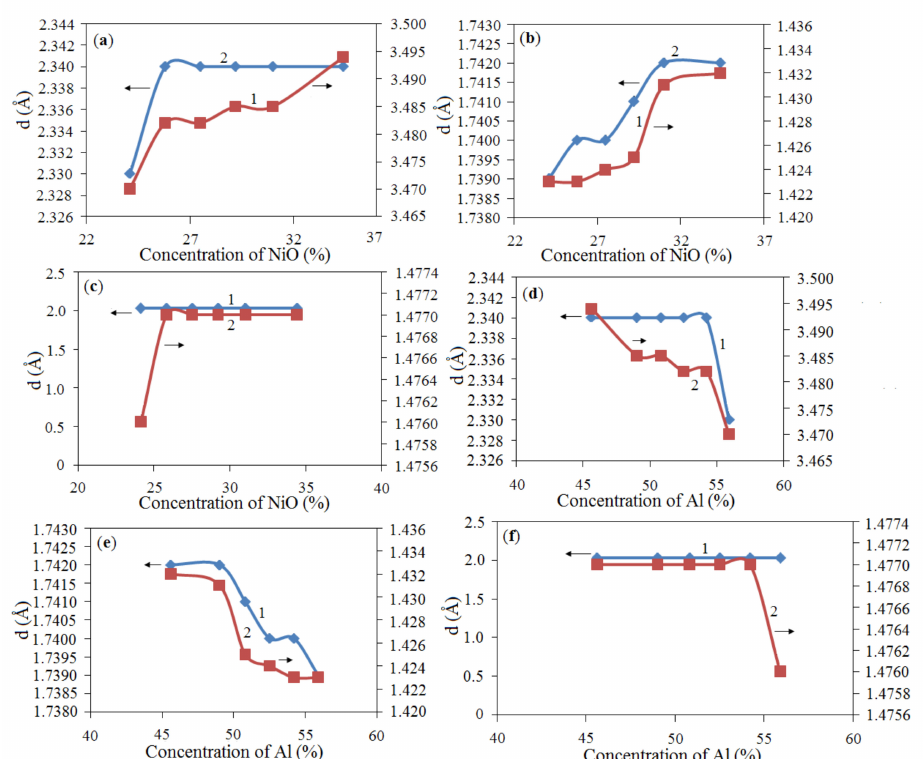
Figure 7. Influence of the catalyst composition on the crystal lattice parameters of the SHS catalyst: ( a ) 1—Al 2 O 3 , 2—Al; ( b ) 1—NiAl 2 O 4 , 2—NiAl; ( c ) 1—Ni, 2—NiO; ( d ) 1—Al, 2—Al 2 O 3 ; ( e ) 1—NiAl, 2—NiAl 2 O 4 ; ( f ) 1—Ni, 2—NiO. The arrow points to the coordinate axis.